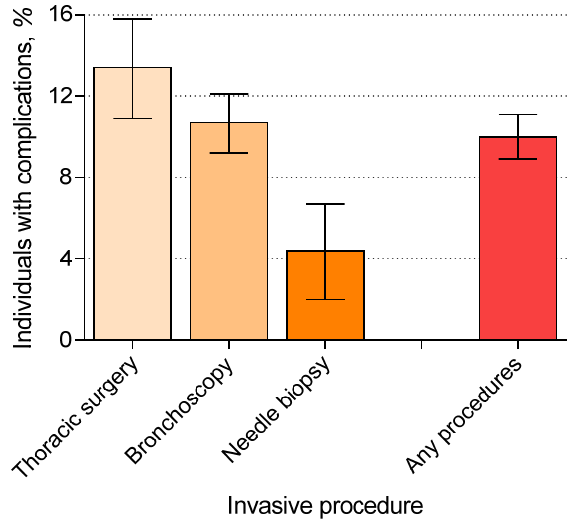
Figure 1. Incremental one-month complication rates (95% confidence intervals) by procedure.